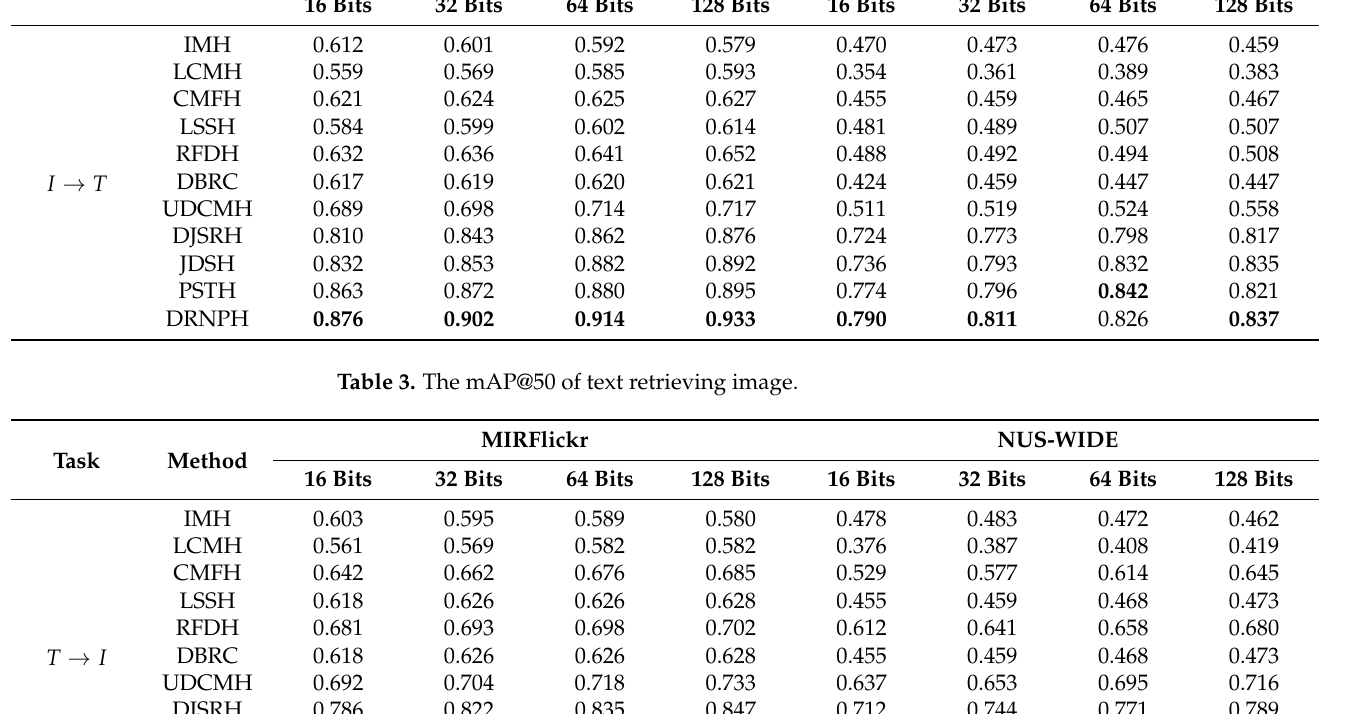
Table 3. The mAP@50 of text retrieving image.